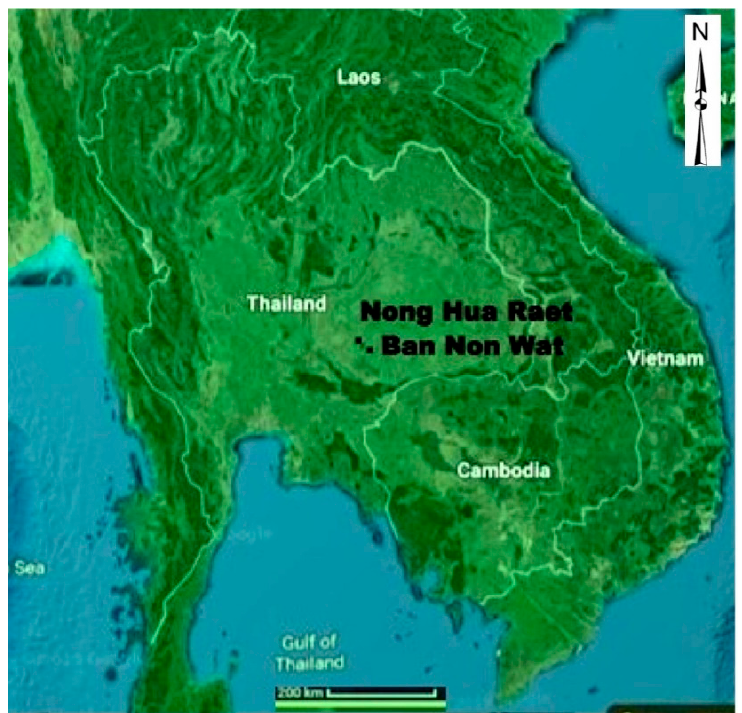
Figure 1. Study sites of Ban Non Wat and Nong Hua Raet at Nakhon Ratchasima province, Non Sung District, Northeast Thailand (Google Earth Image, 2019). Quaternary 2020 , 3 , x FOR PEER REVIEW